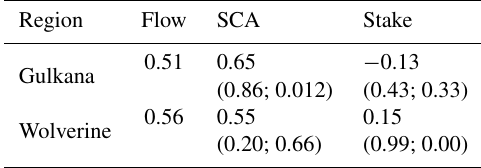
Table 5. Evaluation scores during model validation by mass flux Table 6. Model-averaged evaluation performance scores and linear module representation and watershed, averaged over heat module correlation coefficient, r , between performance of each cryosphere representation. The watershed listed is that which the model is val- observation type and flow during model validation, shown by re- idated for. Evaluation methodology and metrics are described in gion. The watershed listed is that which the model is validated for. Sects. 2.5 and 3.3. The top row for each watershed is the regionally averaged evalua- tion score; the first number in parentheses is r and the second num- ber is the p value, which is an indicator of statistical significance Gulkana Model (typically values less than 0.05 are considered significant). Evalua- tion methodology and metrics are described in Sects. 2.5 and 3.3.